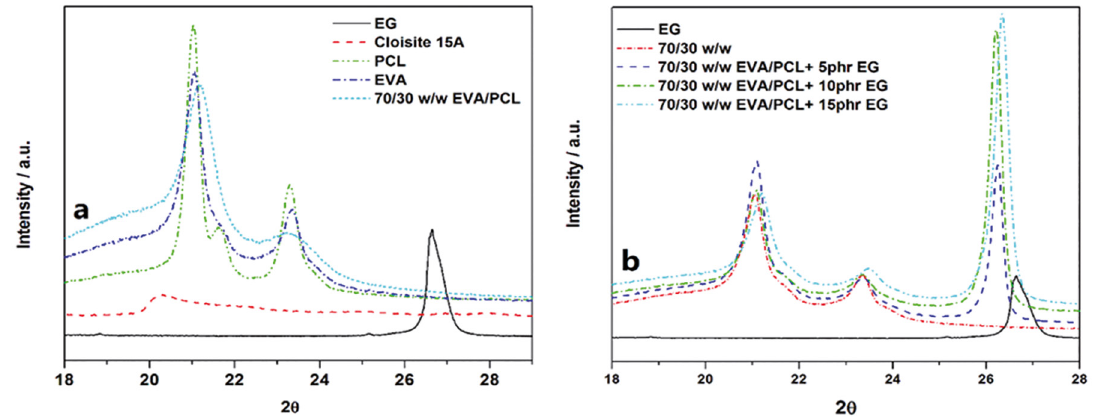
Figure 4: X-ray diffraction patterns of (a) pure materials and (b) blend composites